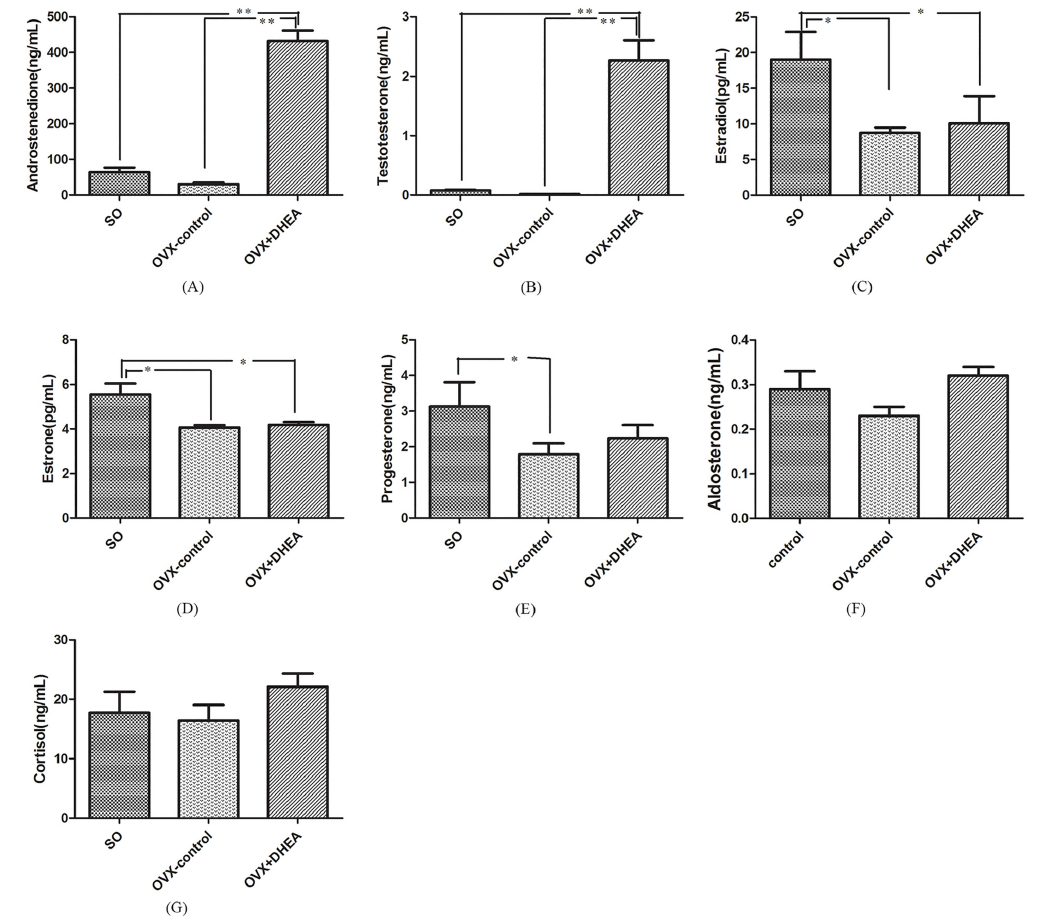
Fig 4. Serum contents of androstenedione (A), testosterone (B), estradiol (C), estrone (D), progesterone (E), aldosterone (F) and cortisol (G) in the ovariectomised (OVX) rats following DHEA administration for 6h. Data are expressed as means ± SE. (n = 10). ** P < 0 . 01 and * P < 0 . 05 , compared with the respective control group.